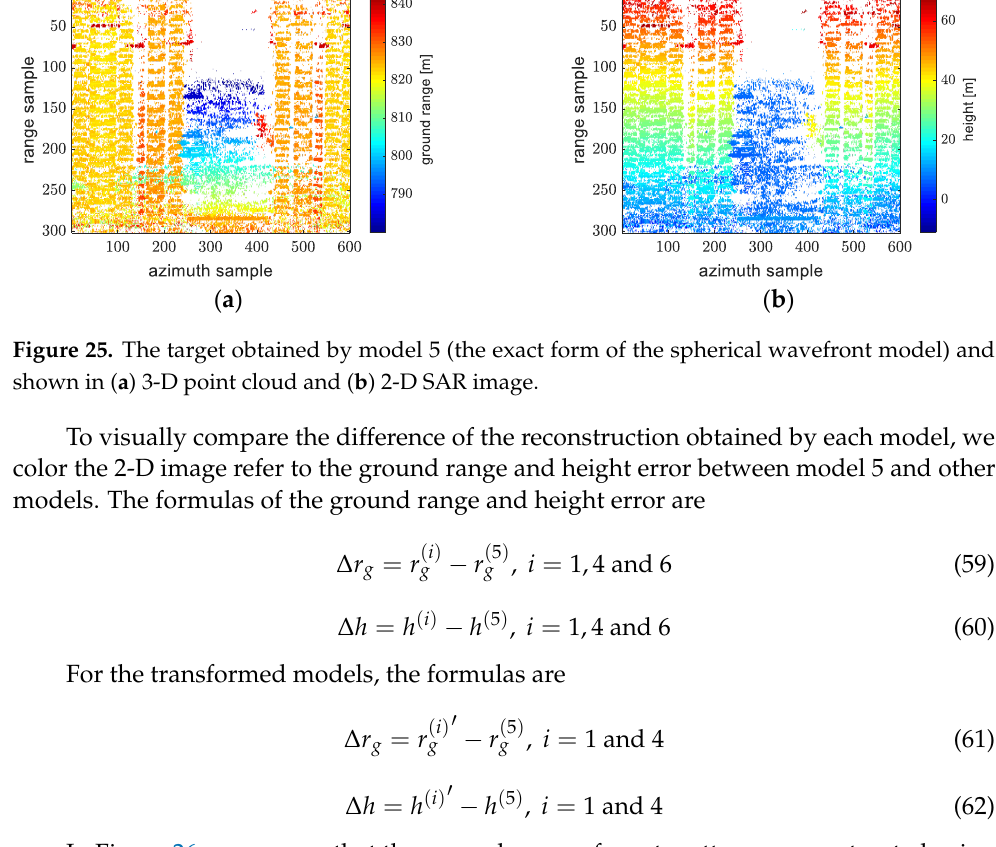
Figure 24. The target extracted from the selected region in experiment 2: ( a ) 3-D point cloud con- taining the target and others; ( b ) 2-D SAR image corresponding to the target. In order to see the ground range and height of the scatterer in each pixel, the 2-D image is colored to refer to ground range and height as shown in Figure 25. White color